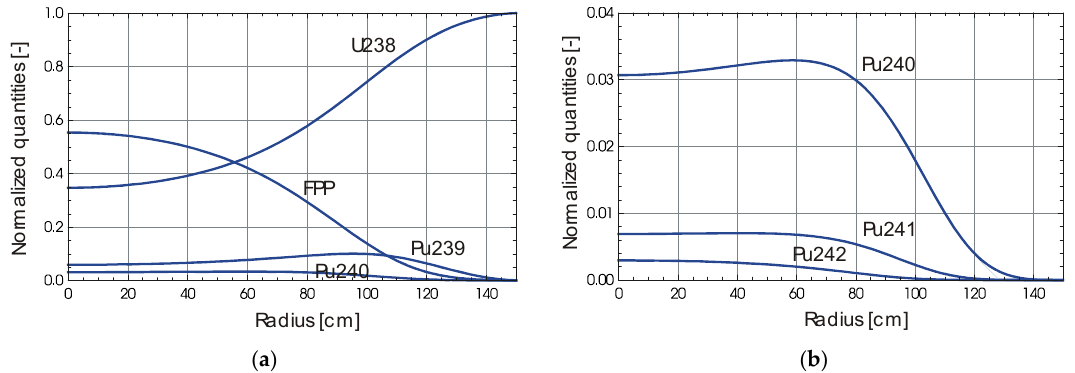
Figure 5. Distributions of main actinide isotopes in the case of radial inward fuel shuffling of Case 2 in Table